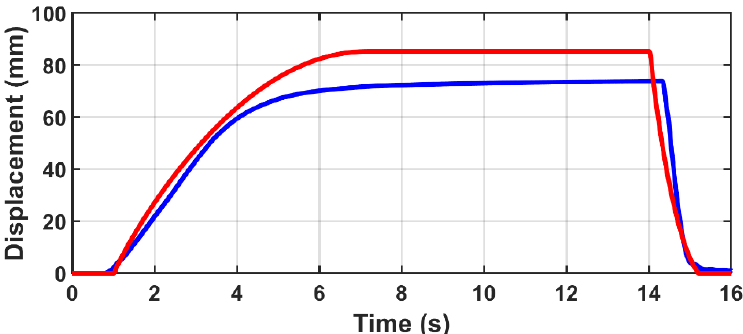
Figure 16. Dynamic responses of the actuator: black line — theoretical results; red line — experimental results for m = 2.5 kg.